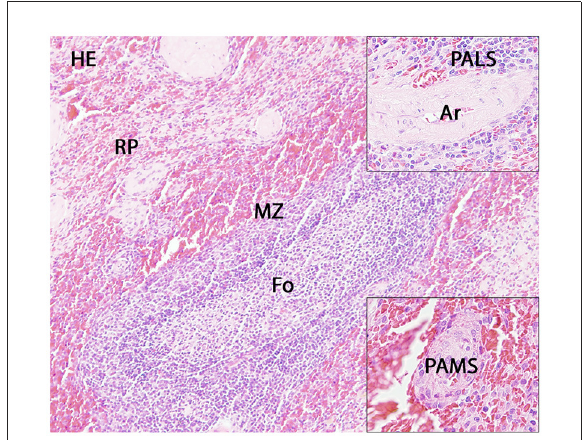
FIGURE1 Histology of the canine spleen. Displayed are a follicle (Fo) with adjacent marginal zone (MZ) and red pulp (RP), the periarteriolar lymphoid sheath (PALS; upper insert) and the periarteriolar macrophage sheath (PAMS; lower insert). Ar: artery.